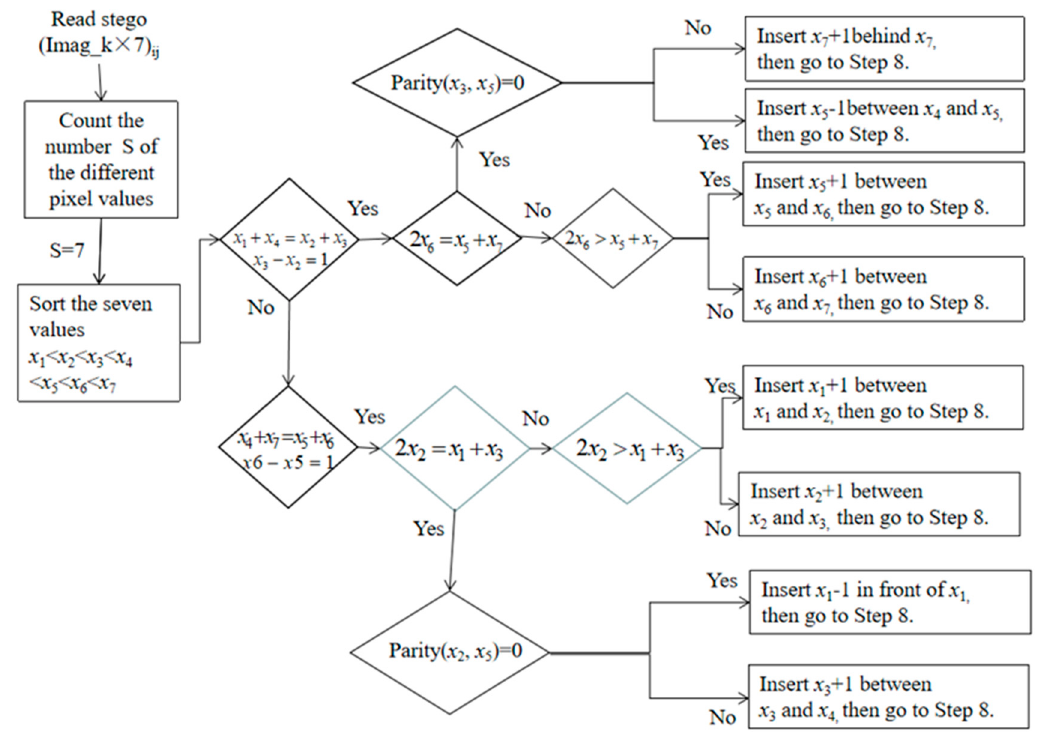
Figure 8. Flowchart of extraction phase when S = 7. Type 43, Note: S indicates the number of different pixel values.